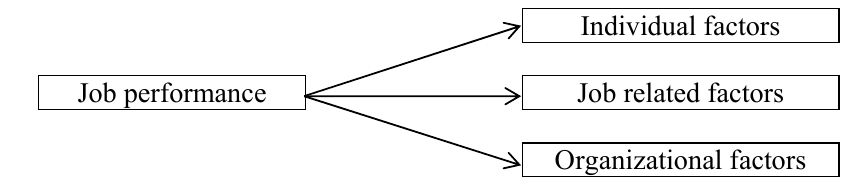
Fig. 1. The proposed study